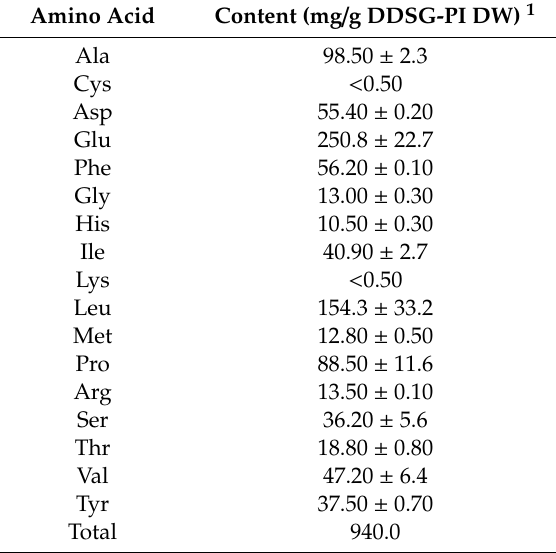
Table 2. Amino acid composition of dried distilled spent grain prolamin isolates